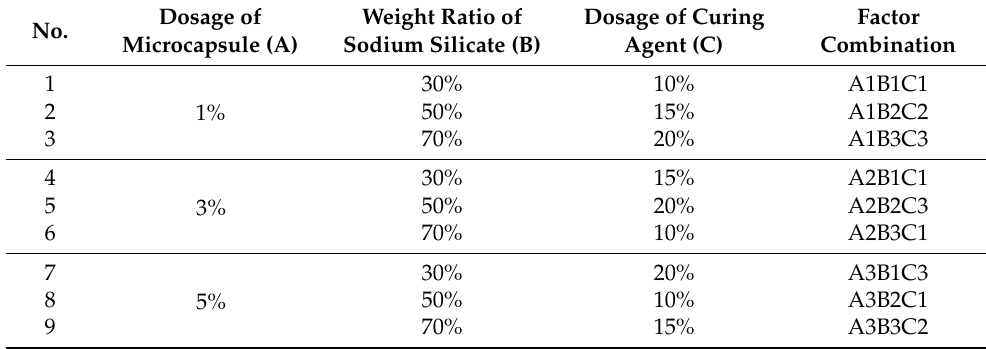
Table 3. Orthogonal test design.